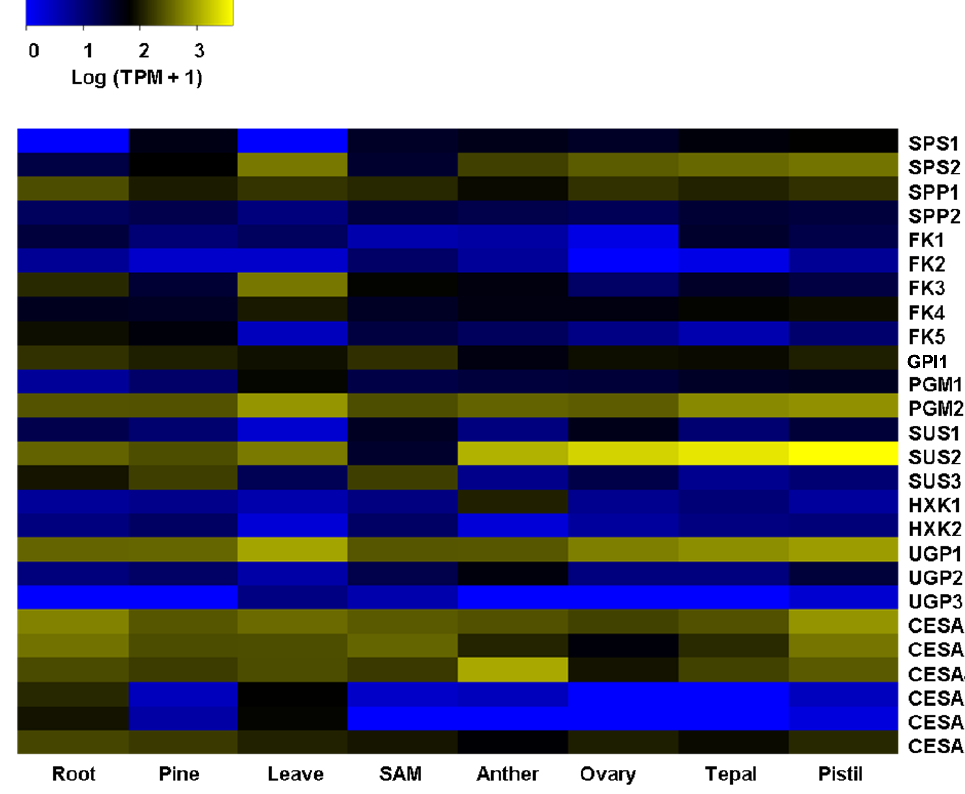
Figure 1. Heatmap depicting expression profiles of orthologous genes involved with cellulose biosynthesis across several tissues/organs of A. tequilana . Genes enlisted on the left side are plant biosynthetic genes for cellulose according to the literature. Sucrose PhosphateSsynthase ( SPS ), Sucrose Phosphate Phosphatase ( SPP ), Fructokinase ( FK ), Phosphoglucomutase ( PGM ), Sucrose Synthase ( SUS ), Hexokinase ( HXK ), UDP-Glucose Ppyrophosphorylase ( UGP ), and Cellulose Synthase ( CESA ). At the bottom, the last row indicates the RNA-sequencing samples previously reported [16]. SAM: Shoot apical meristem. Hierarchical clustering was conducted on the log (TPM+1). In the color key, yellow denotes high expression, black refers to medium, and blue denotes low expression.